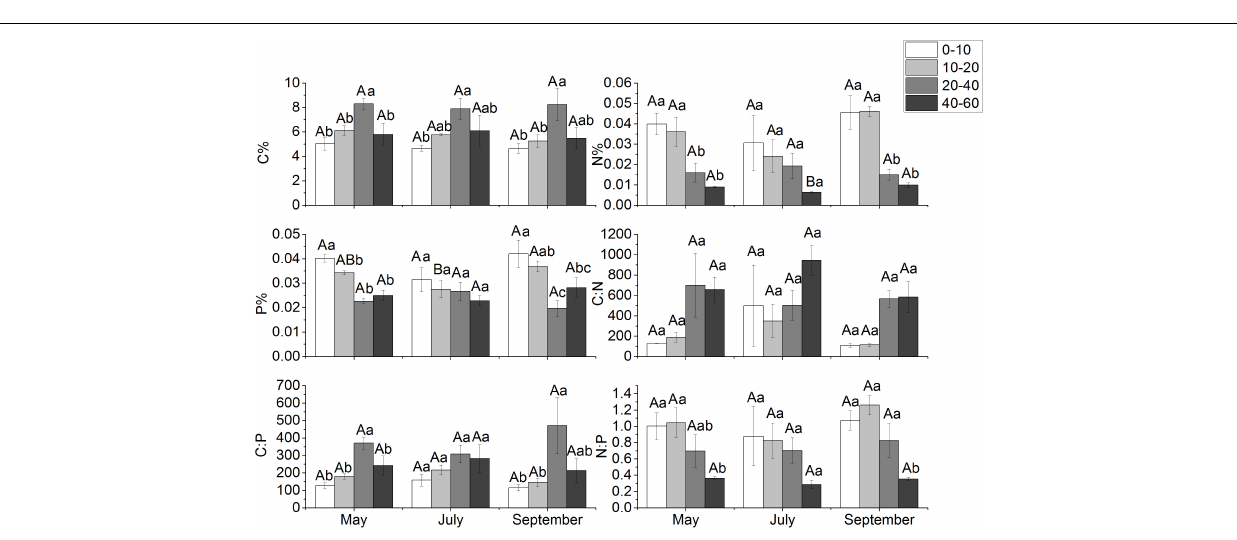
FIGURE 4 | Seasonal dynamics of C, N, and P stoichiometry in different soil layers. Different capital letters indicate the significant difference in the same soil layer in different months, and different small letters indicate the significant difference of different soil layers in the same